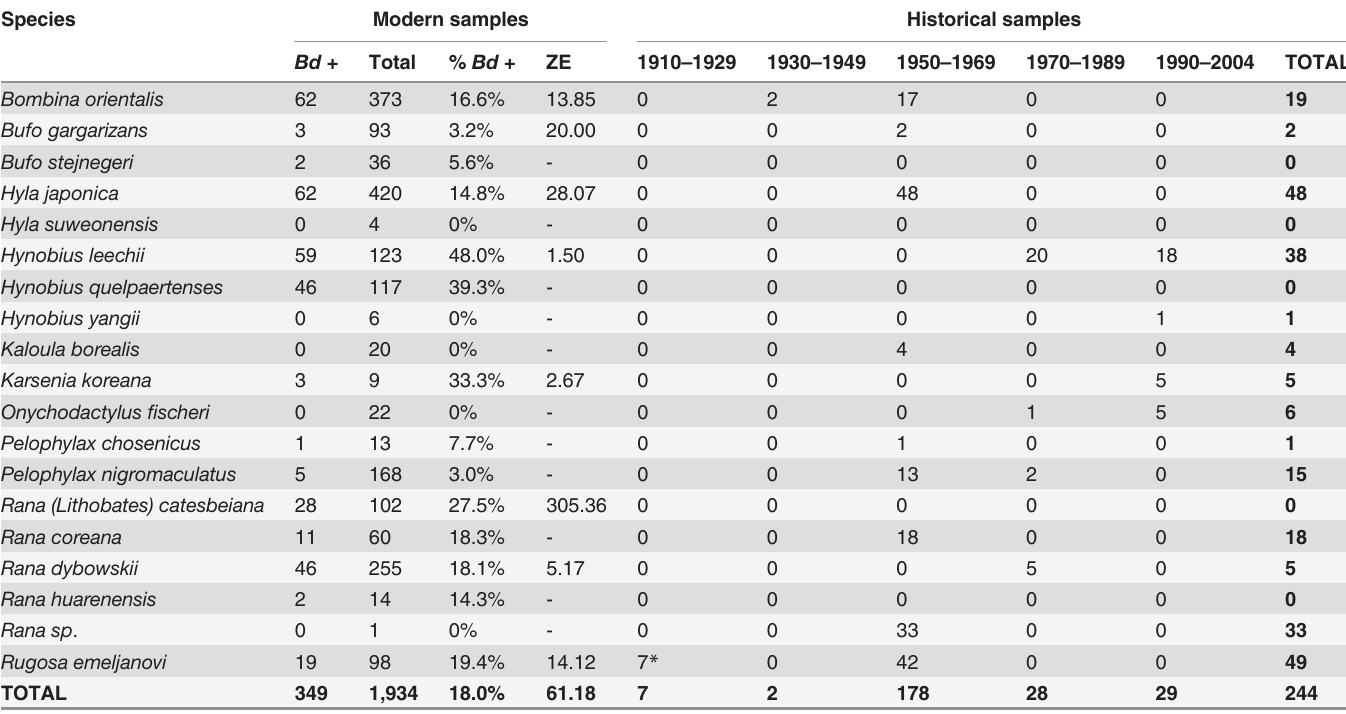
Table 1. Comparison of modern and historical specimen